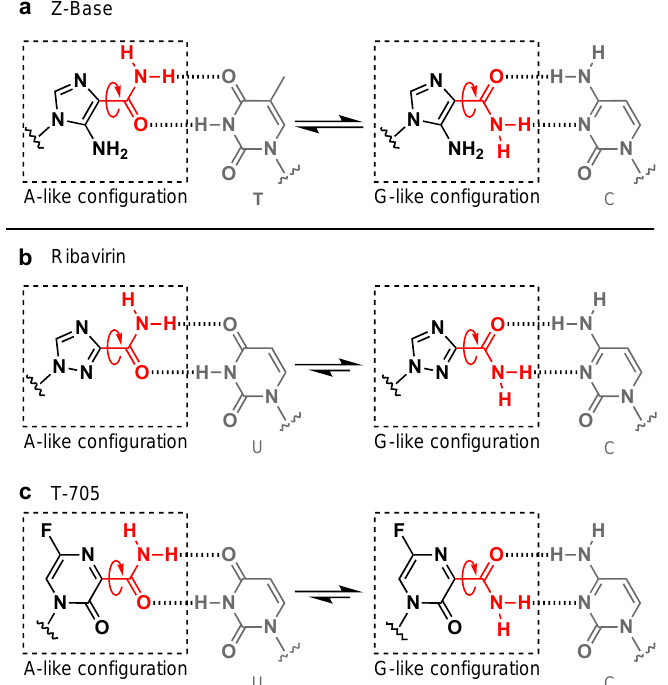
Figure 1. Structures of ambiguous nucleobases with a carboxamide group. ( a ) Z-base, ( b ) ribavirin, and ( c ) T-705. Rotatable carboxamide groups are highlighted in red.